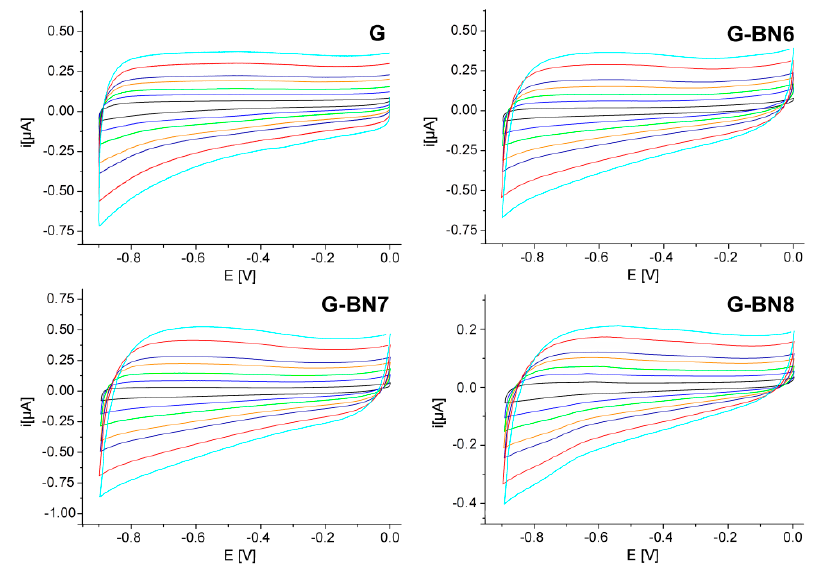
Figure 6. Cyclic voltammograms of pristine graphene ( G ), graphene functionalized with BN6 C 60 fullerene derivative ( G-BN6 ), BN7 C 70 fullerene derivative ( G-BN7 ) and Sc 3 N@C 80 fullerene derivative BN8 ( G-BN8), registered in 3 M KOH with a scan rates of: 20 (black), 50 (blue), 100 (green), 150 (orange), 200 (dark blue), 300 (red) and 400 mV s − 1 (cyan).